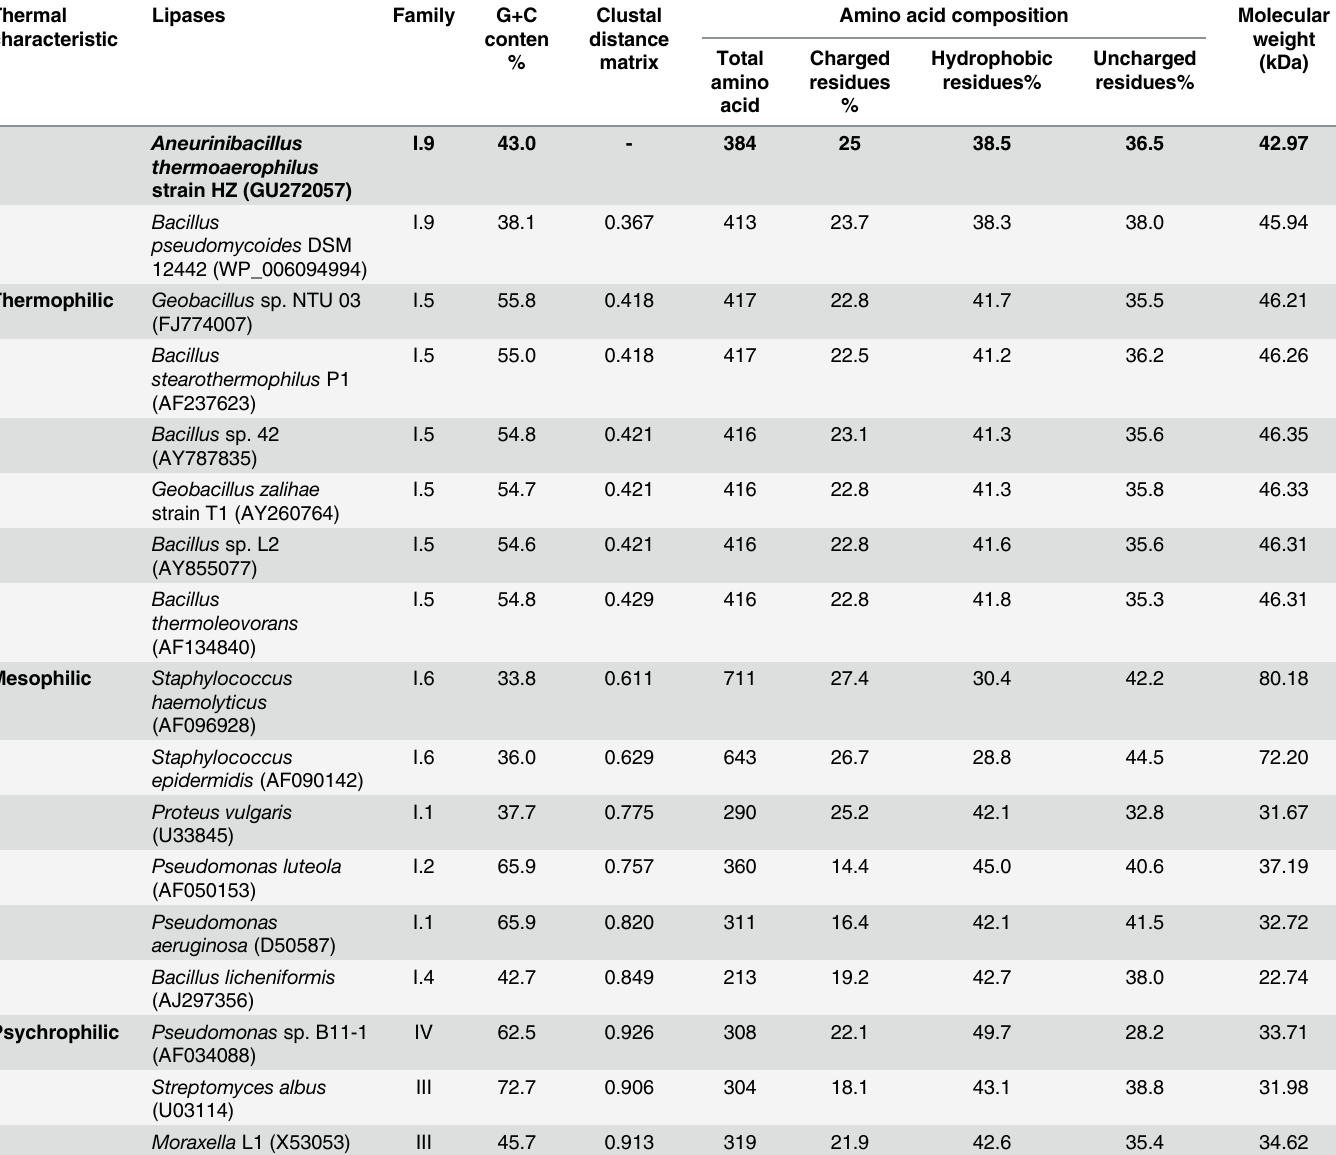
Table 1. Family, G+C content, Clustal distance matrix, amino acid composition and molecular weight of various lipases derived from different bac- teria sources. Thermal